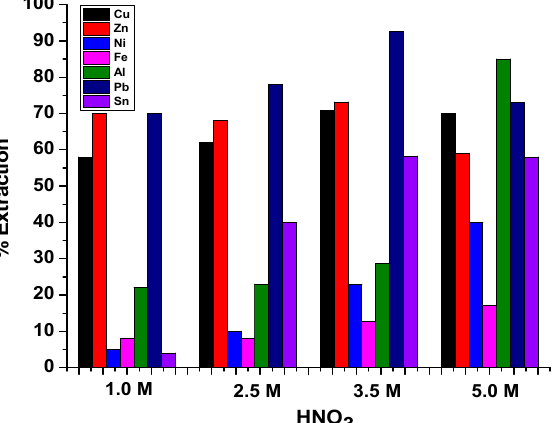
Figure 6. Comparative extraction efficiencies of Cu and Zn, and the co-extraction of other metals from WPCBs using HNO 3 lixiviant, 50 g/L pulp density, 25 °C, 300 rpm, and 12 h.